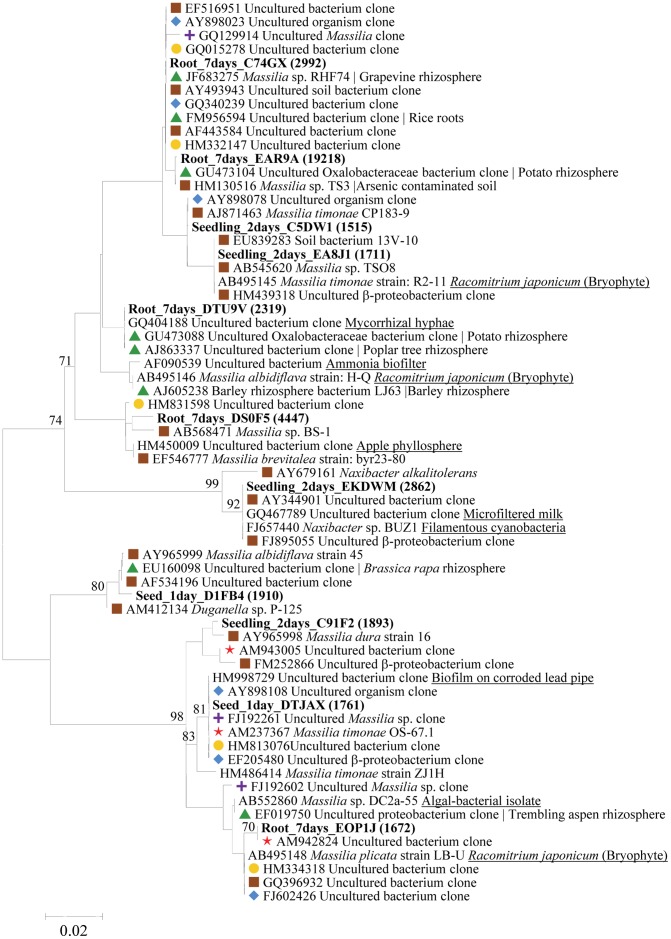
Neighbor-joining tree depicting representatives of the most abundant Oxalobacteraceae OTUs (in bold; number of sequences represented are in brackets) and related sequences from the NCBI database.The tree was calculated using the Kimura two-parameter model. The scale bar represents number of substitutes per site. Numbers at the nodes indicate bootstrap values (1000 replicates). Symbols indicate sequence origin: brown square- soil; green triangle- rhizosphere; yellow circle- human and mouse skin swabs; blue diamond- fresh water; red star- air and dust; and purple cross- clean room. Sequences from other origins are underlined.